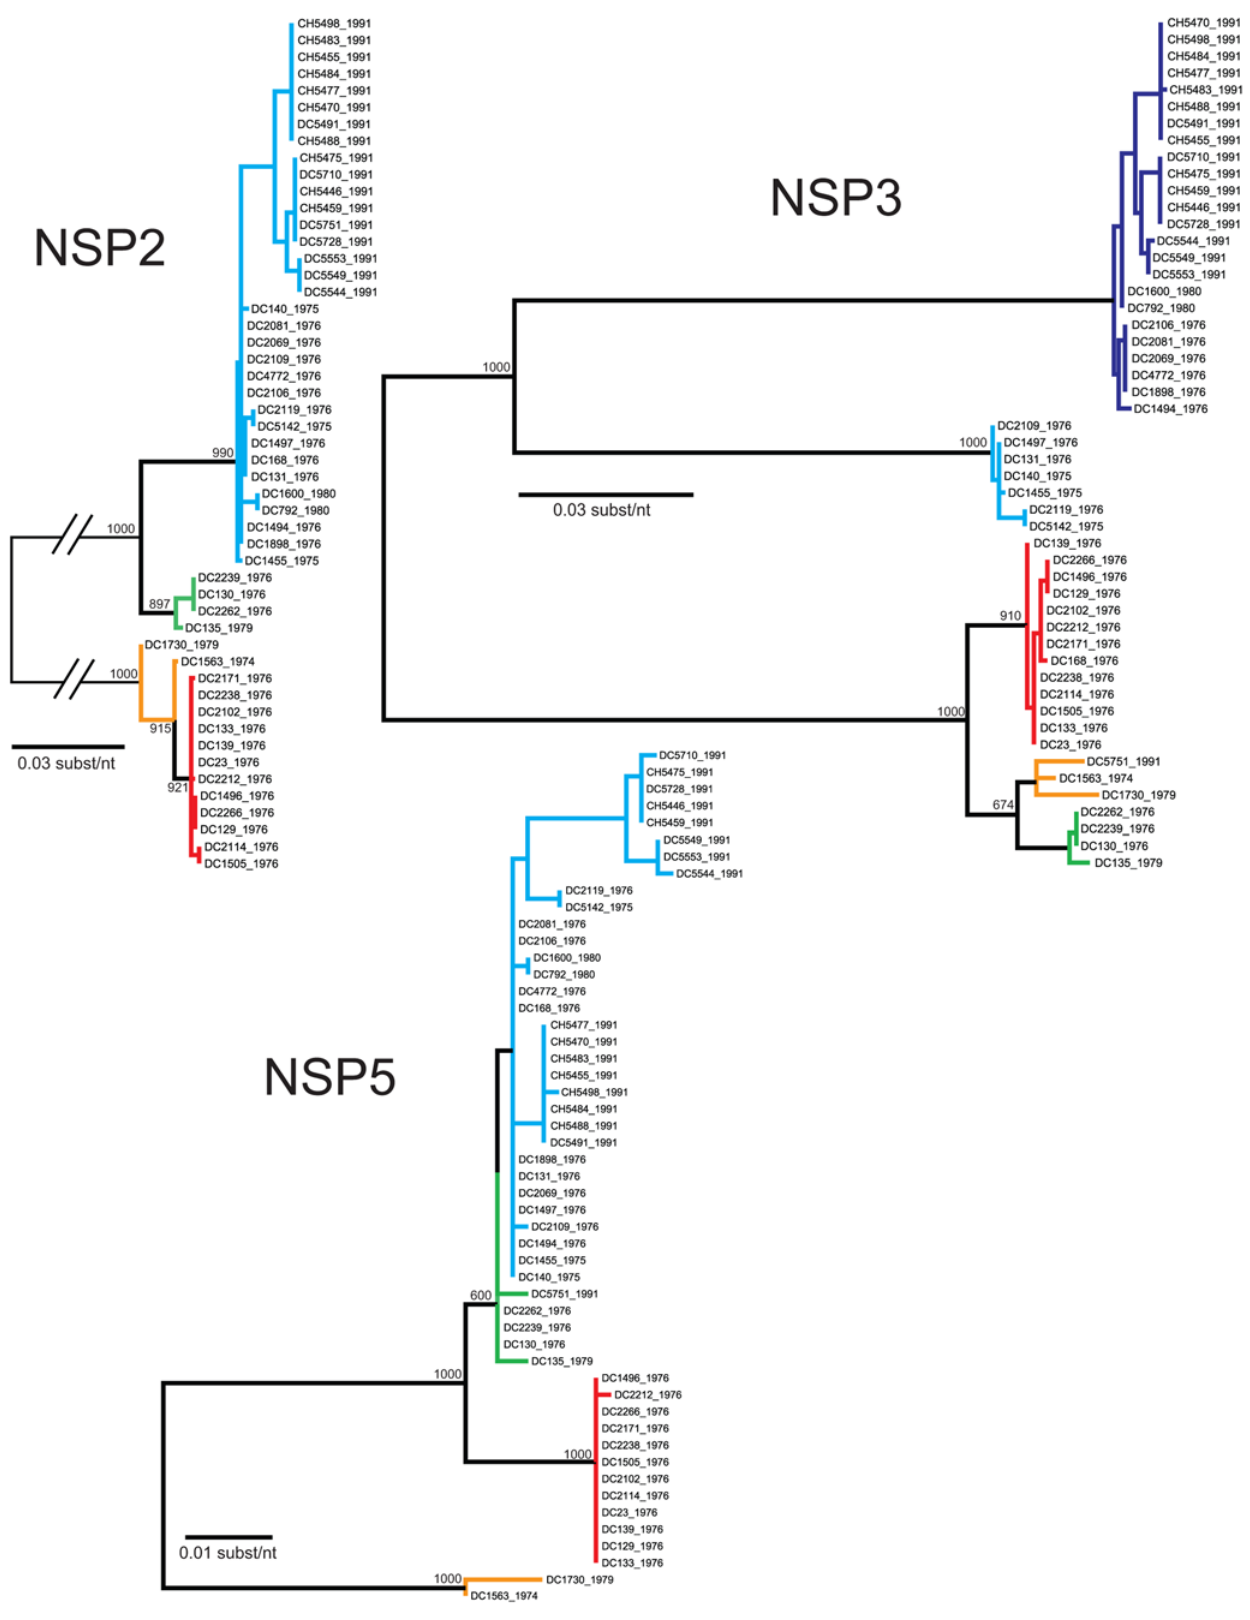
Figure 4. Phylogenetic Relationships Among the Individual Genes of the G3P[8] RVs: NSP2, NSP3, and NSP5. Details are given in the legends for Figures 2 and 3.